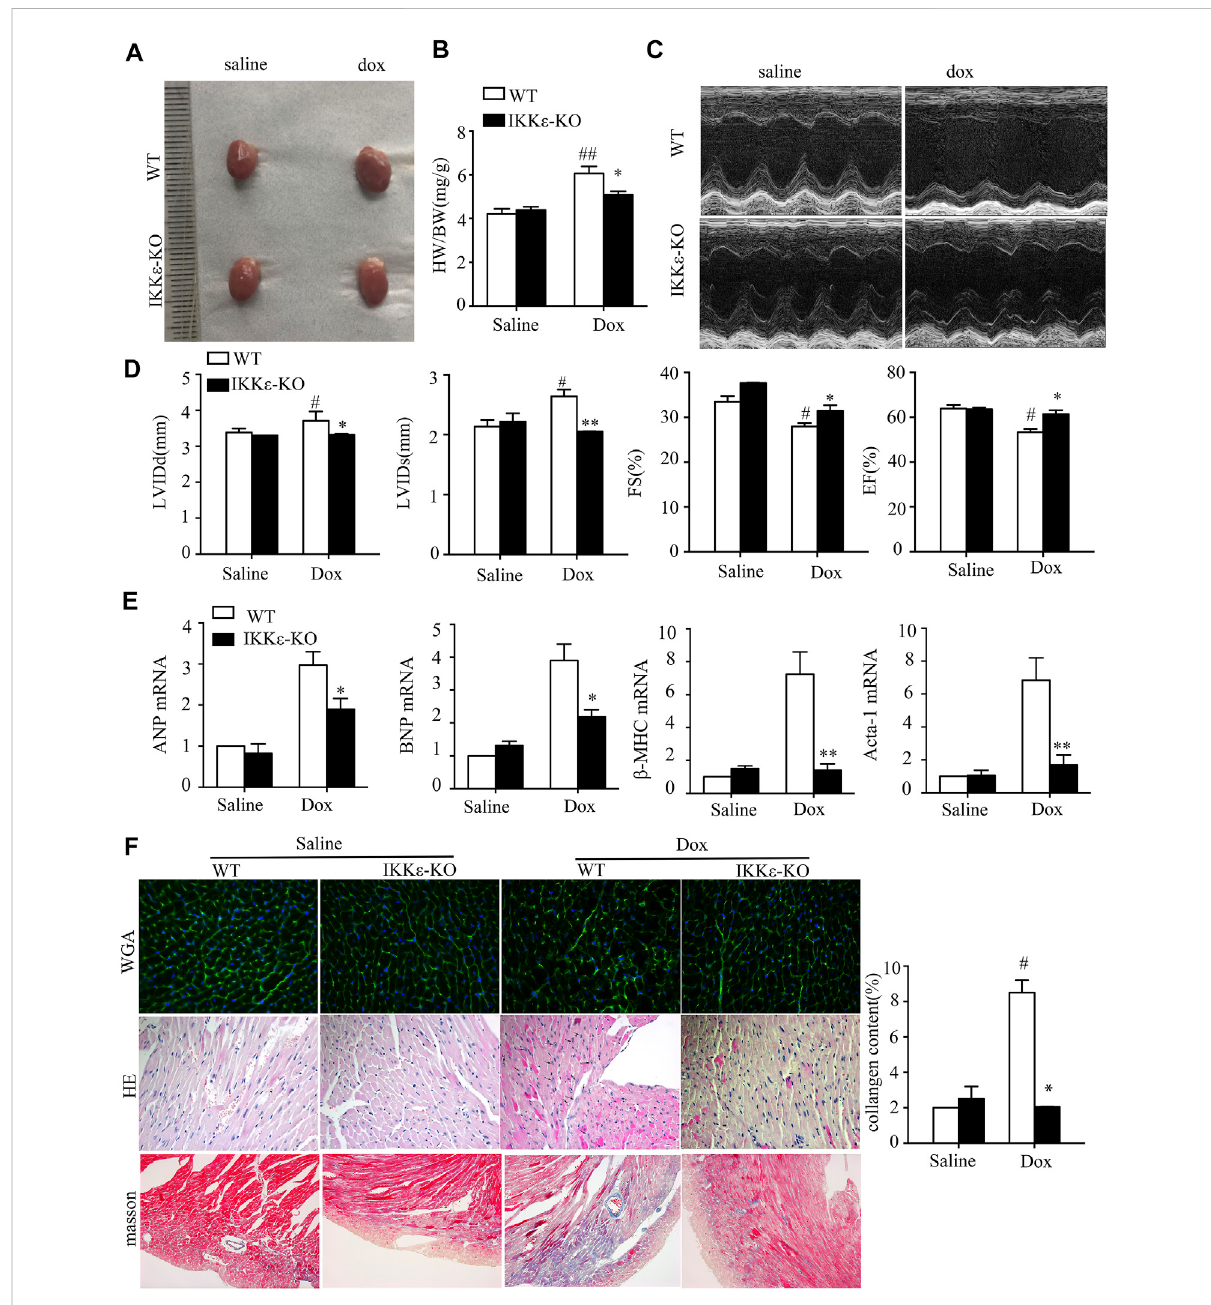
FIGURE 2 De fi ciency of IKK ε attenuated the development of Dox-induced dilated cardiomyopathy. (A) . Representative images of the hearts of WT and IKK ε -KO mice. (B) . The ratio of heart weight/body weight between WT and IKK ε -KO mice under Dox stimulation ( n = 6 mice each group in HW/BW; vs.SalineorWTDox,* p < 0.05) (C,D) .Representativeimagesandparametersofechocardiography(LVIDd,LVIDs,FS,andEF)ofWTandIKK ε -KOmice injected with saline or Dox ( n = 6 mice per experimental group; vs. Saline or WT Dox, * p < 0.05). (E) . The mRNA analysis of markers of heart failure (ANP, BNP, Acta-1, and β -MHC) in the heart of WT or IKK ε -KO mice after Dox injection ( n = 4 mice per experimental group; vs. Saline or WT Dox, * p < 0.05). (F) . Representative images of WGA staining, HE staining and Masson staining of WT and IKK ε -KO mice ( n = 4 mice per experimental group,400xforHEandWGAstaining;200xforMasson).ThesmallarrowsinHErefertothechangednucleiafterdoxorubicinstimulation.Analysisof collagen content of WT and IKK ε -KO mice ( n = 4 mice per experimental group, vs. Saline or WT Dox, * p <